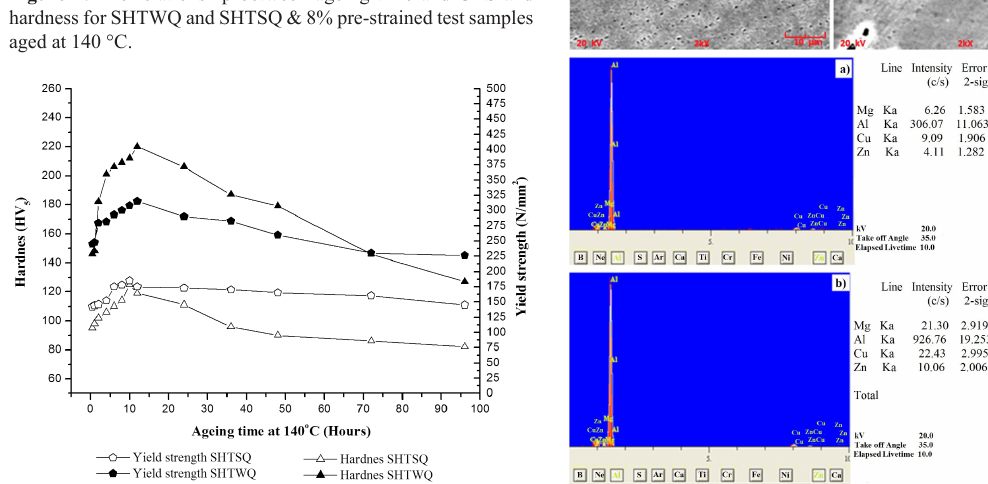
Figure 5. The relationship between ageing time and hardness and yield strength for SHTWQ and SHRSQ & 8% pre-strained test samples aged at 140 °C.